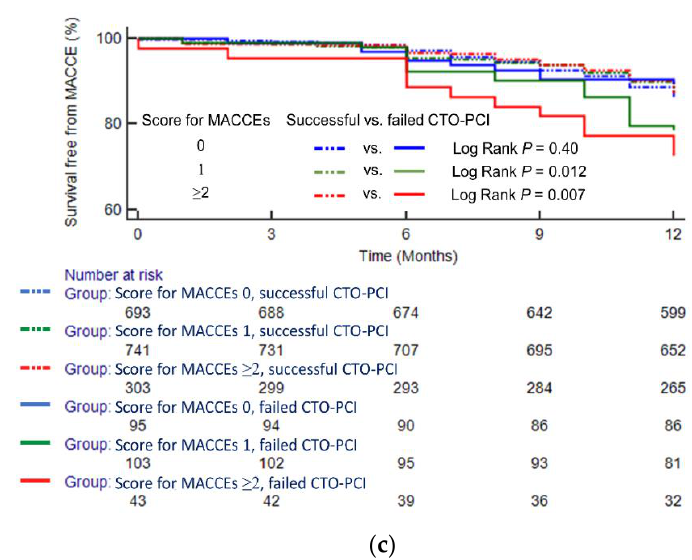
Figure 7. Survival free from MACCE after CTO-PCI: ( a ) survival free from MACCEs stratified by procedural results, ( b ) survival free from MACCEs stratified by procedural results, ( c ) survival free from MACCEs stratified by score for MACCEs among patients with successful and failed CTO-PCI. Abbreviations: CTO, chronic total occlusion; MACCEs, major adverse cardiac and cerebrovascular events; PCI, percutaneous coronary intervention.